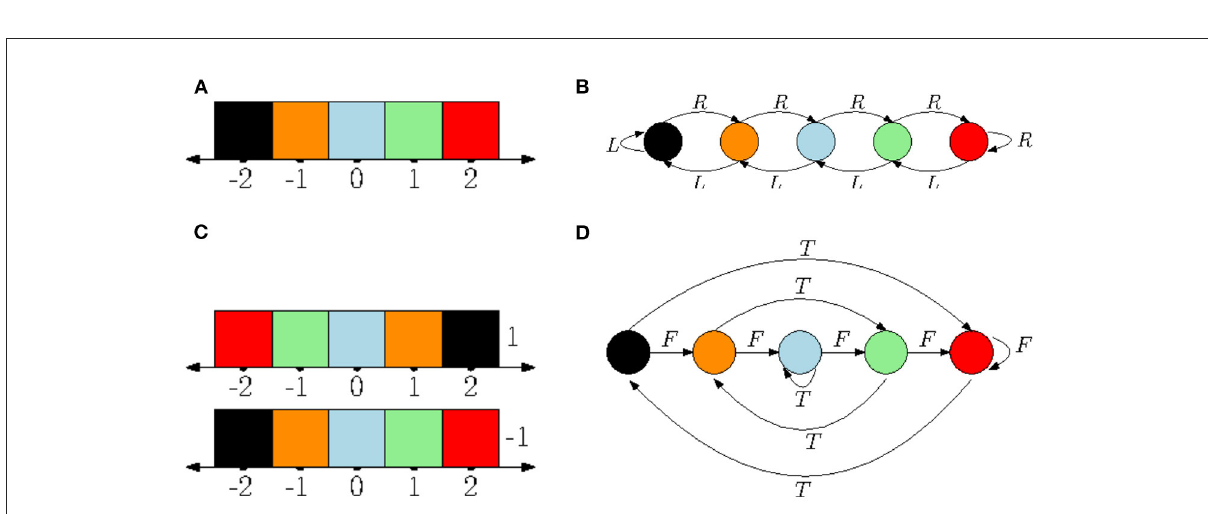
FIGURE7 (A) State space of the agent 0 categorized by h 0 , states that belong to the same class are colored with the same color. (B) Resulting quotient X 0 / h 0 for the agent 0. (C) State space of the agent 1 categorized by h 1 , states that belong to the same class are colored with the same color. (D) Resulting quotient X 1 / h 1 for the agent